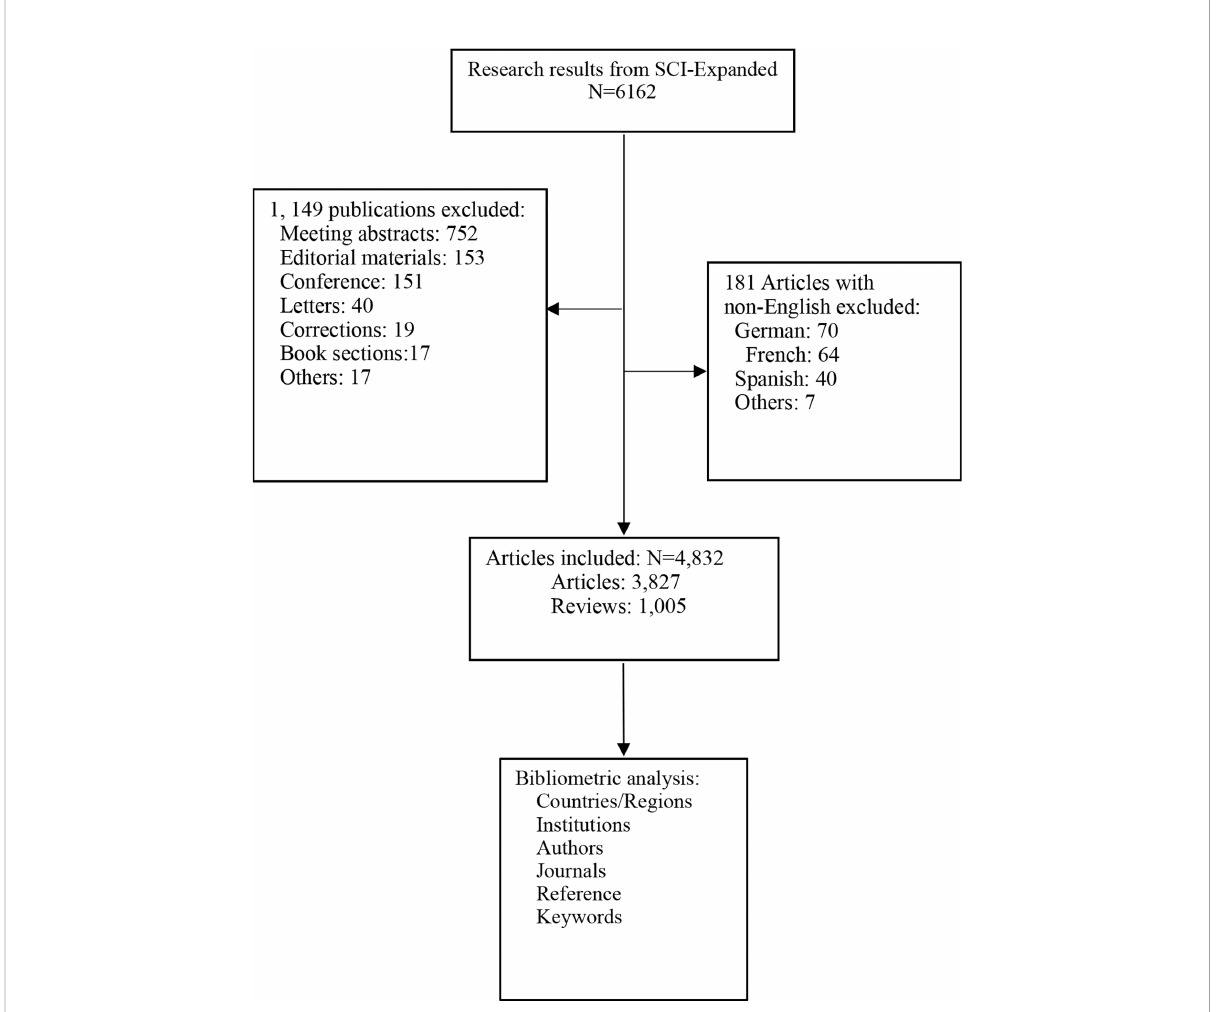
FIGURE 1 Flow chart of articles